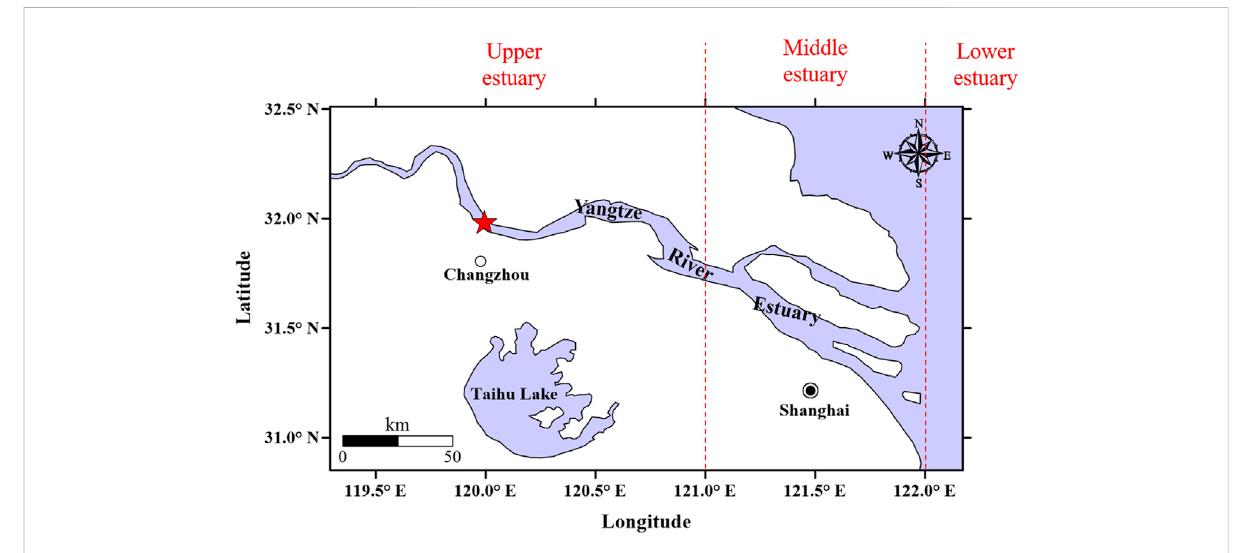
FIGURE 1 Study area (red star) in the upper Yangtze River